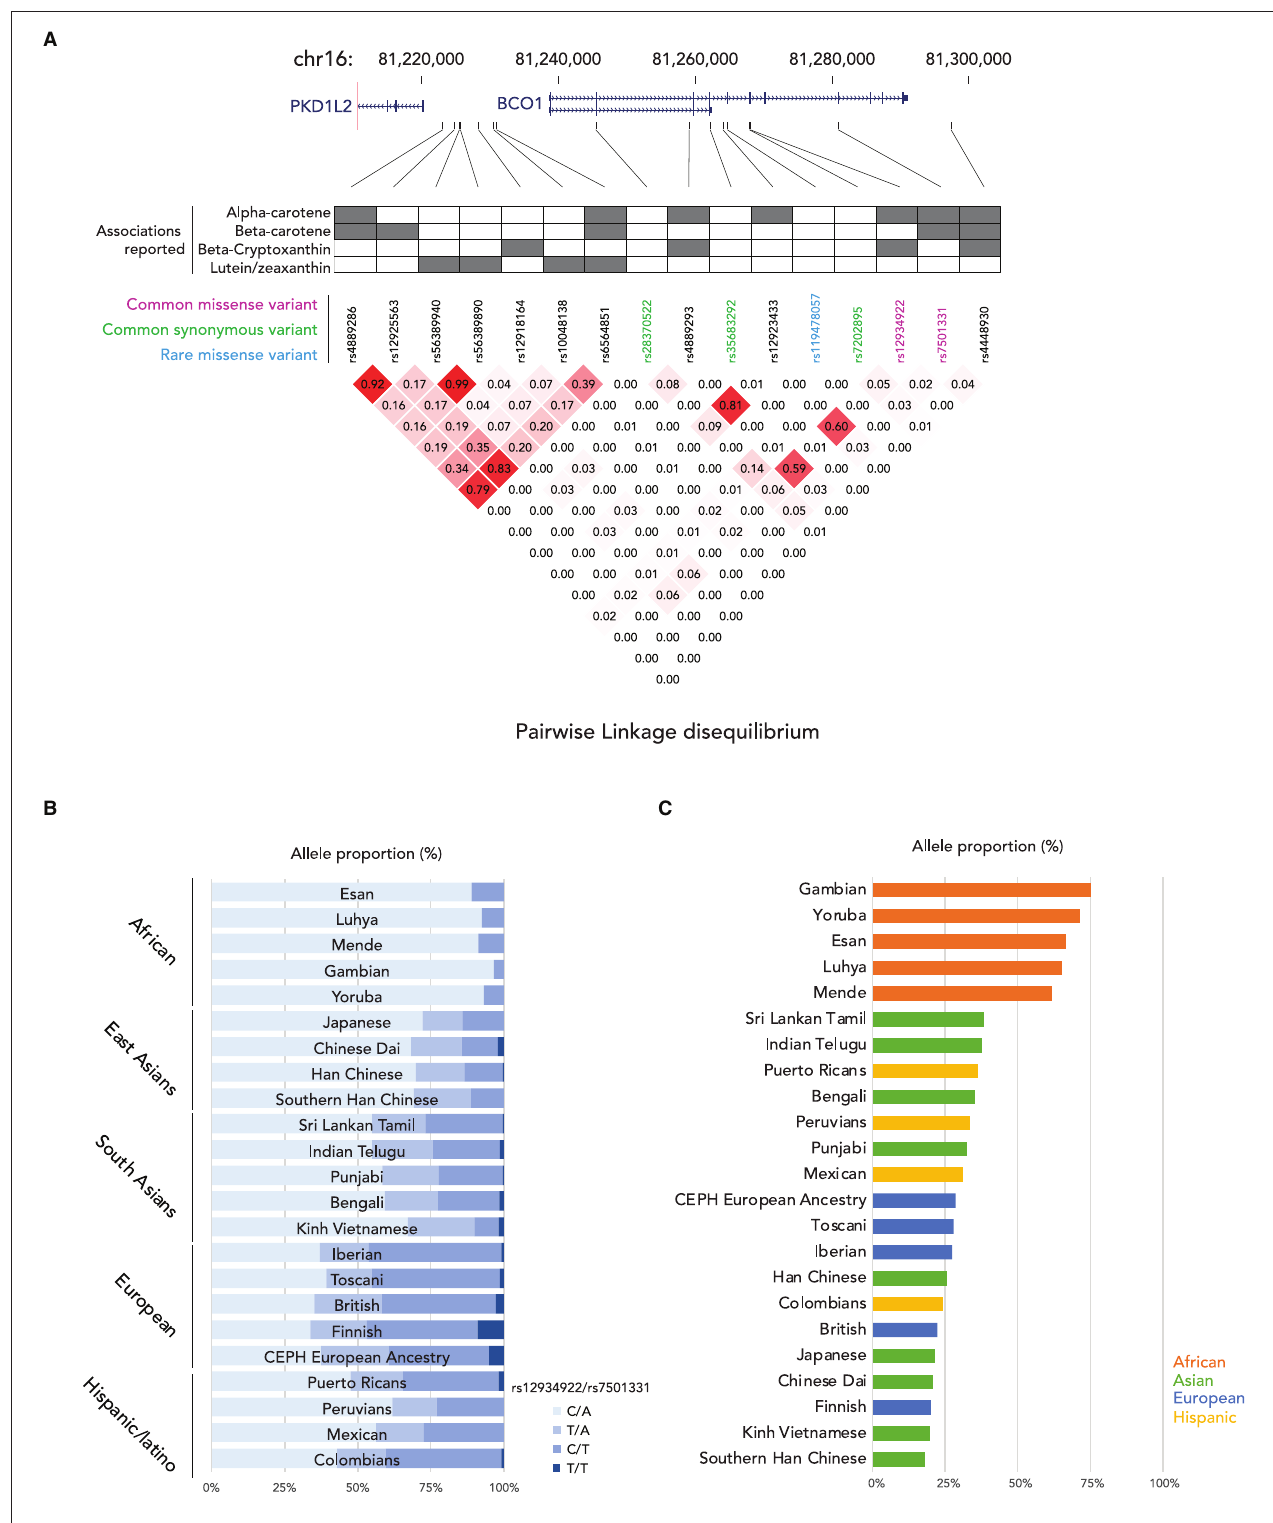
FIGURE 1 | Summary of genetic variations of BCO1 gene. (A) (top) locations of genetic variants in BCO1 locus; (middle) the association to the provitamin A status of each genetic variation; (bottom) Linkage Disequilibrium (LD) plot, the numbers in the boxes indicate the LD status and darker red shading illustrate higher LD; (B) Proportions of BCO1 gene activity genotypes by ethnic groups. (C) Proportion of low BCO1 gene activity haplotype defined by Hendrickson’s estimation by ethnic groups.